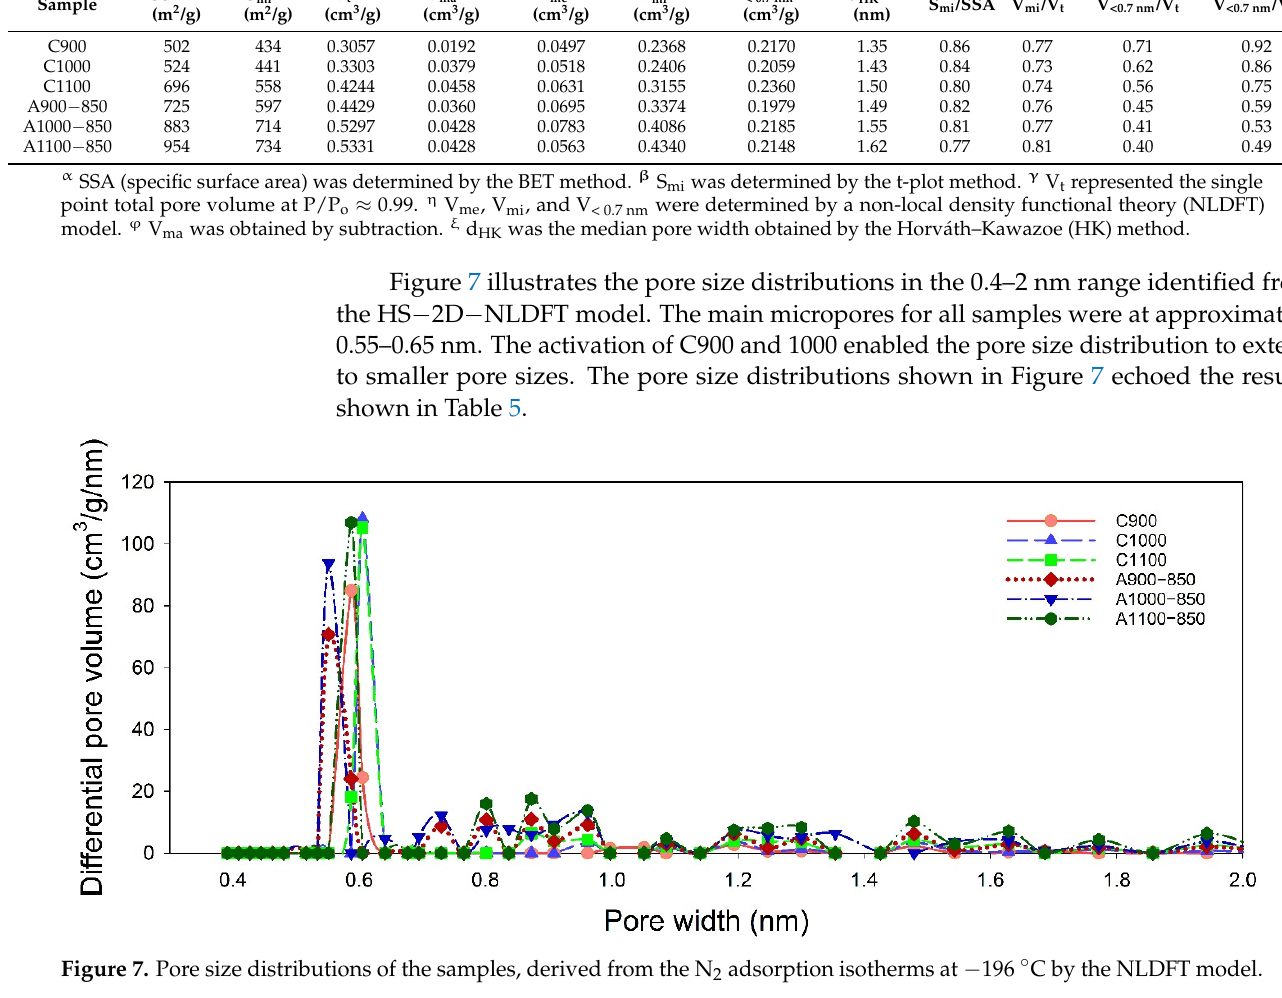
Table 5. Surface features of the samples determined from the N 2 adsorption–desorption isotherms at − 196 ◦ C. α Sample SSA (m 2 /g)